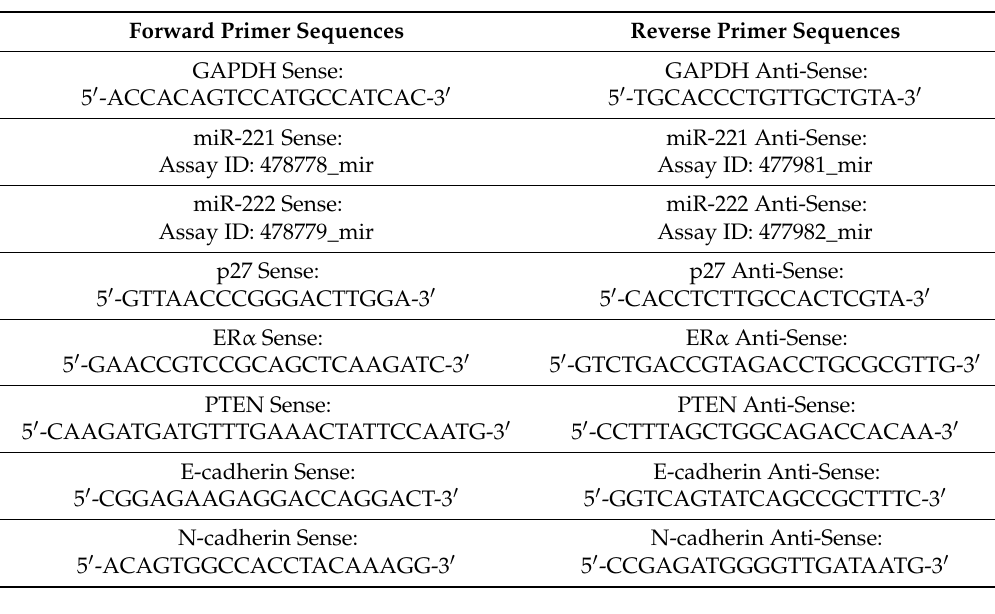
Table 1. qRT-PCR primer